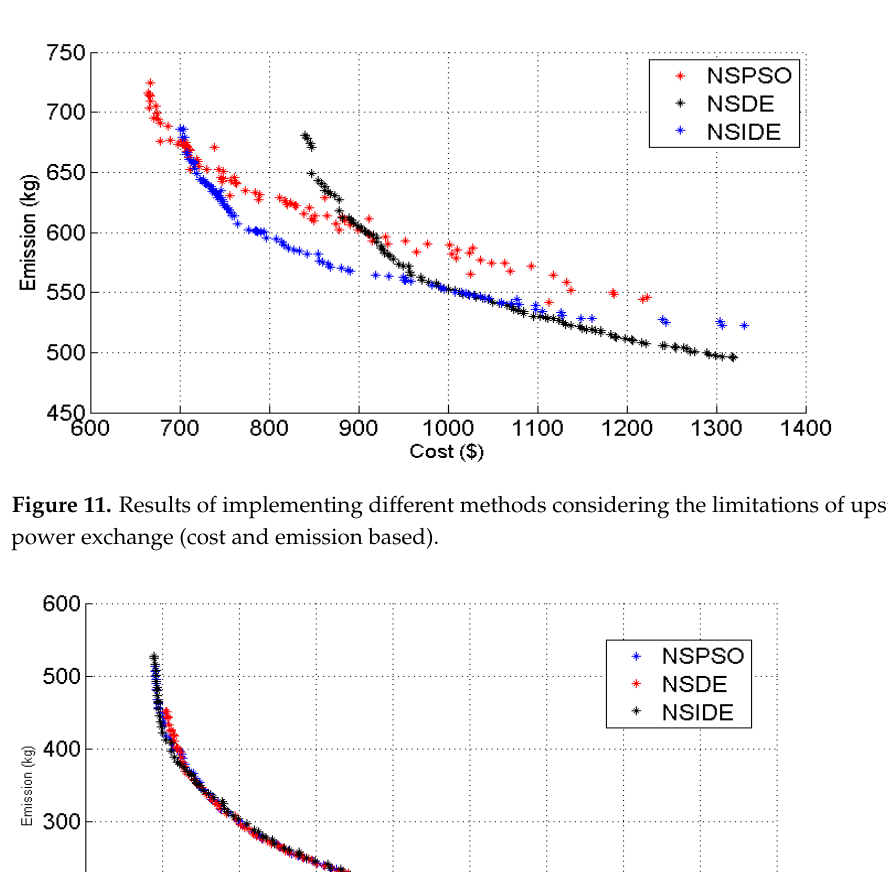
Figure 10. Comparison of Pareto Fronts with and without limitation of upstream grid exchange (cost and emission based).